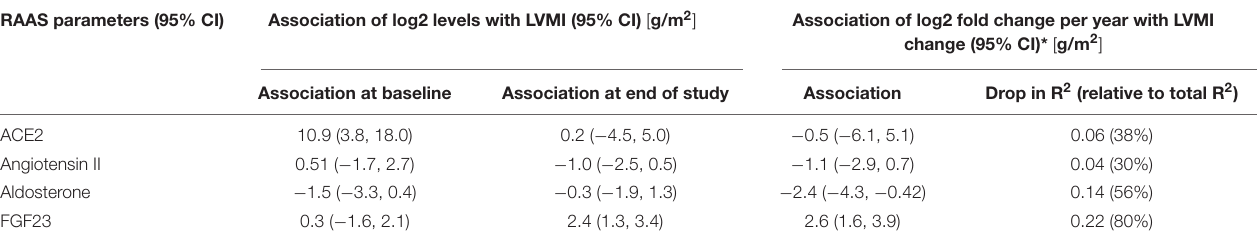
TABLE 5 | Association of renin-angiotensin-aldosterone system (RAAS) parameters and FGF23 with left ventricular mass index (LVMI). RAAS parameters (95%